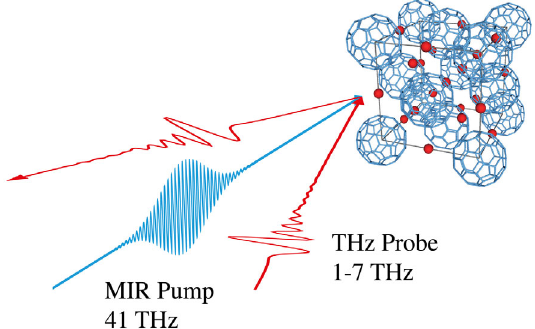
FIG. 3. Sketch of the experimental geometry. K 3 C 60 is excited with vertically polarized midinfrared pulses. The THz probe pulses are polarized in the horizontal